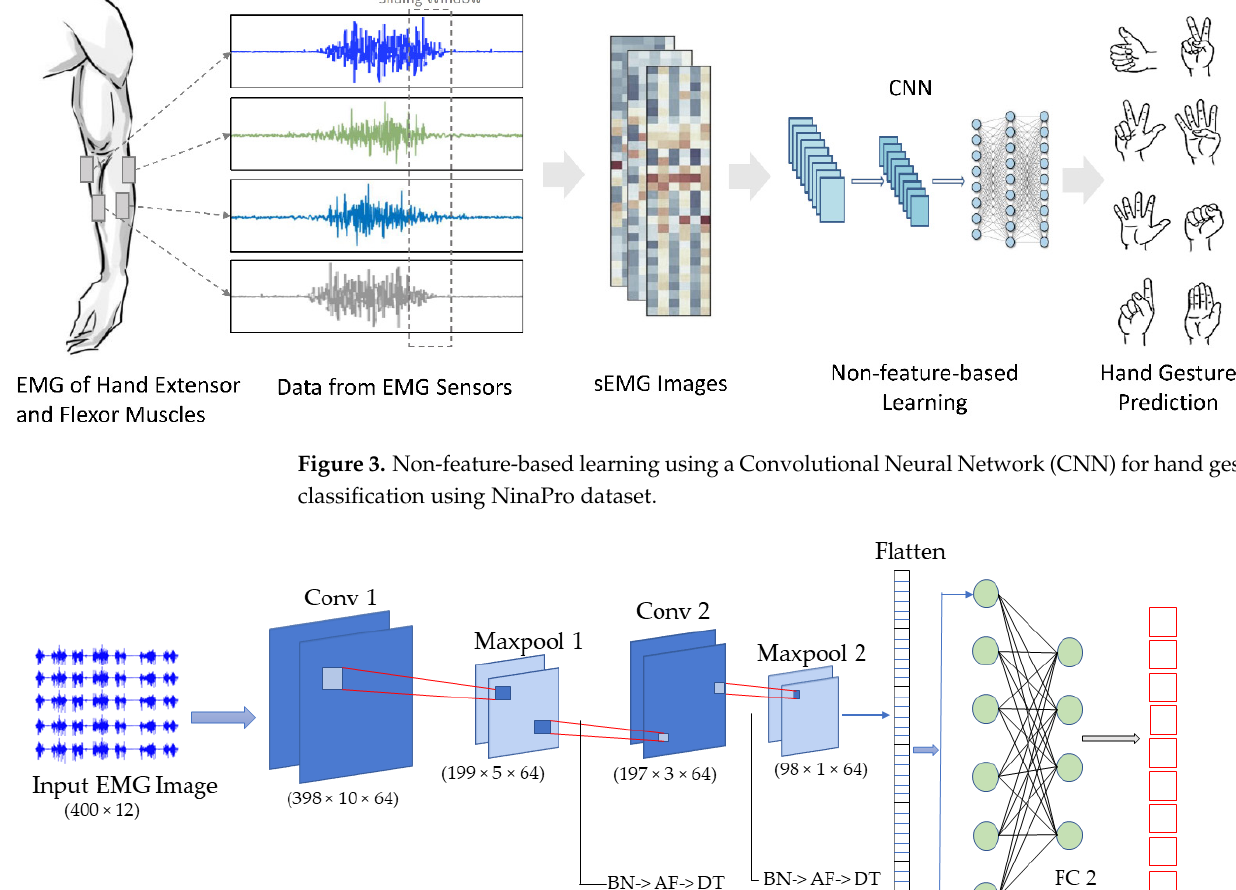
Figure 3. Non-feature-based learning using a Convolutional Neural Network (CNN) for hand gesture classification using NinaPro dataset.